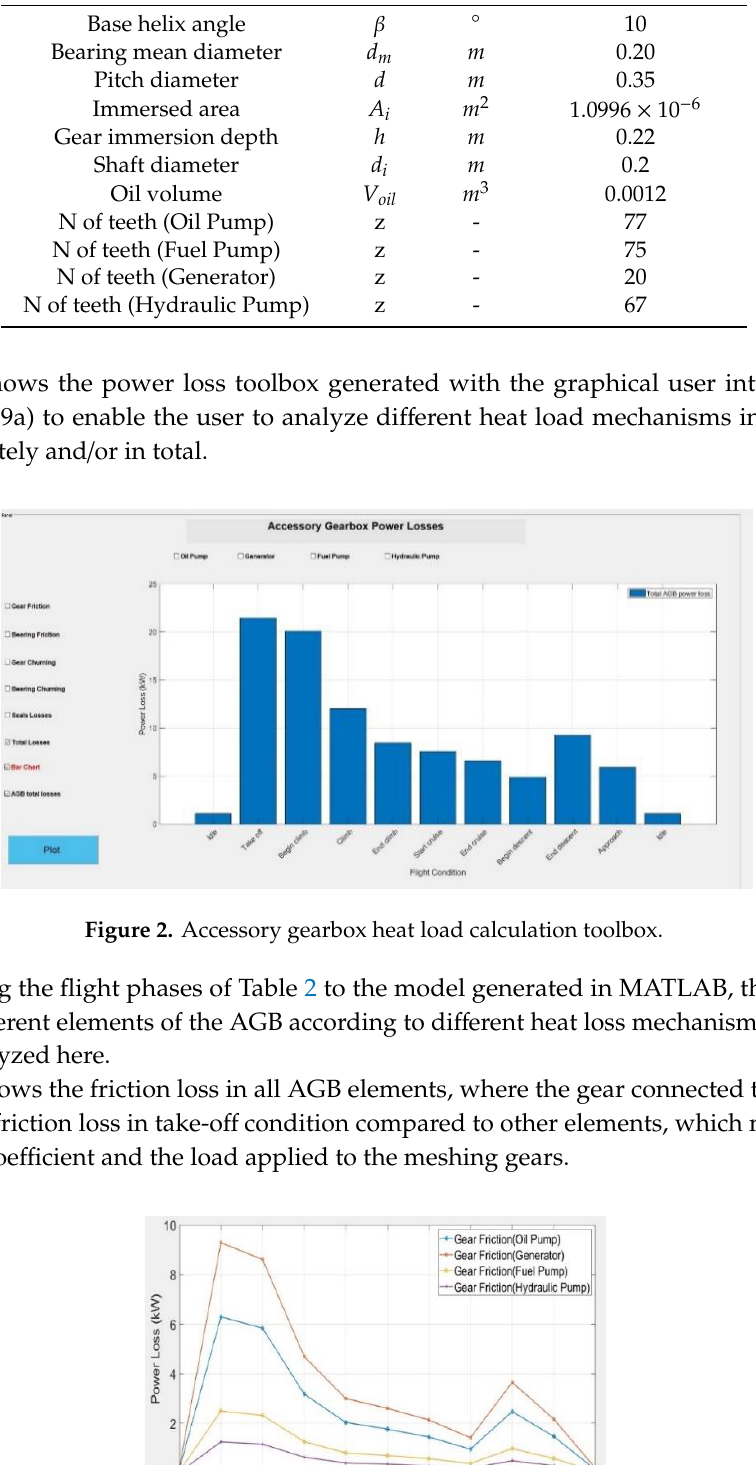
Figure 4. Power losses due to bearing friction. Figures 5 and 6 show the losses due to gear and bearing churning in all AGB components, respectively. Regarding Section 3, the fluid viscosity and density index influence the churning losses where the oil properties change with oil temperature and operating conditions. The fuel pump has a high loss compared to the generator due to the influence of gear diameter. It can be seen that the impact of the oil temperature on the churning power losses is mainly reflected in the density and dynamic viscosity of the oil. The churning losses at take-off condition seem to have a high value on all AGB components, due to change the viscosity of the oil. Additionally, the oil fill level influences the churning power loss, the losses increase with increasing the immersion level of the gear teeth. Figure 5. Power losses due to gear churning.